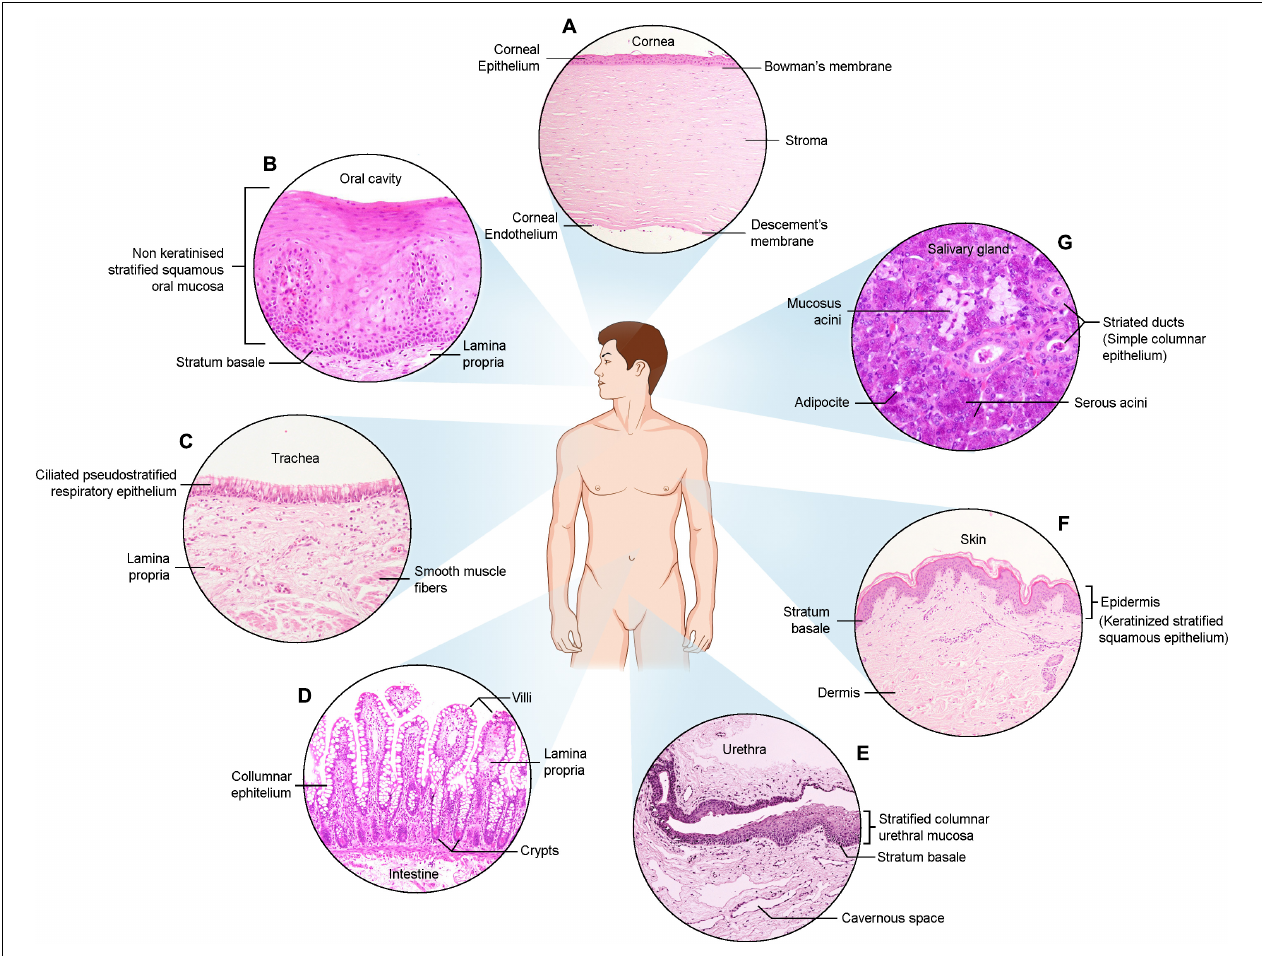
FIGURE 1 | Haematoxylin and Eosin images of the described epithelia. (A) Cornea (B) Oral cavity (C) Trachea (D) Intestine (E) Urethra (F) Skin (G) Salivary